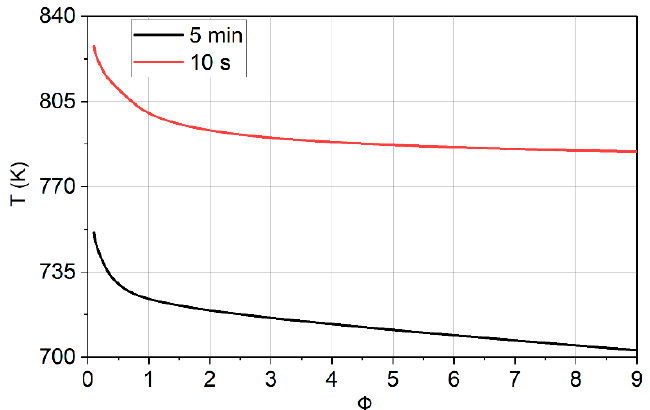
Figure 8. The influence of the equivalence ratio on the autoignition temperature.